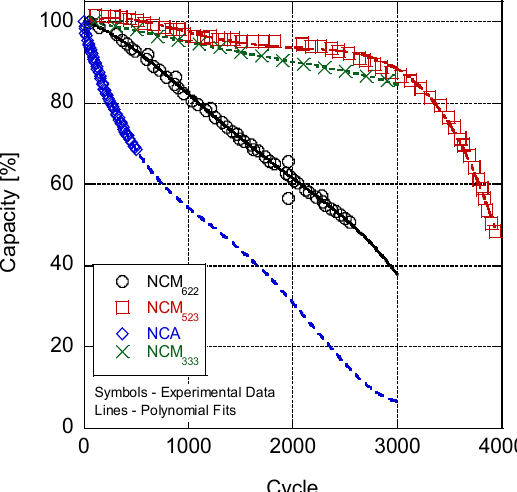
Figure 8. Loss in capacity of representative batteries based on cycle life.